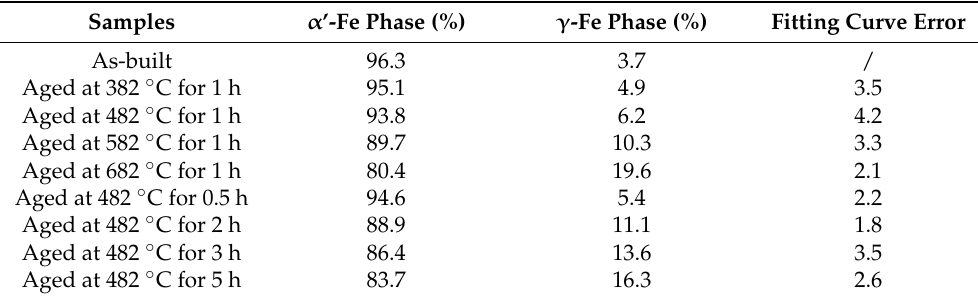
Table 2. Volume fractions of the α ’-Fe and γ -Fe phases in the SLM 17-4 PH steel samples under different